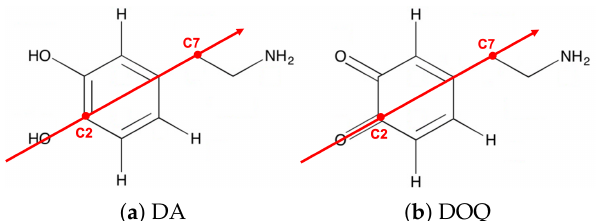
Figure 2. DA and DOQ. The adsorbate structures of DA and DOQ are shown here. The corresponding protonated species, DAH + and DOQH + , have an additional hydrogen in their positively charged amine groups. The C2–C7 vectors (red arrows) are used to define the orientation and tilt of the adsorbates above the carbon